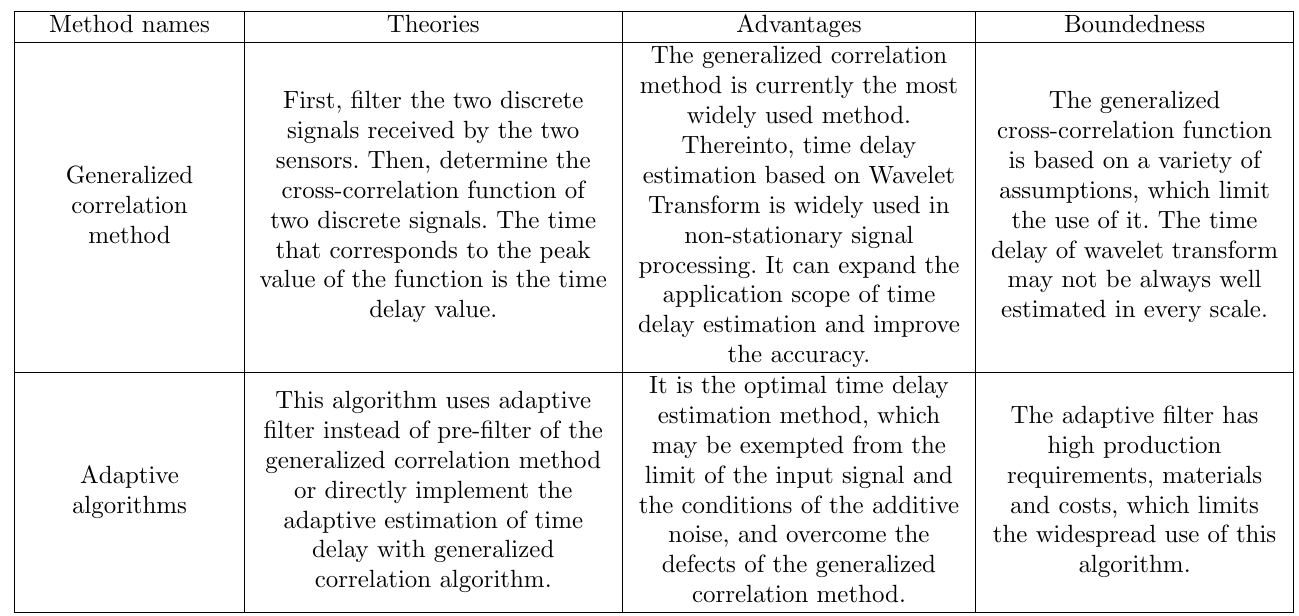
Table 7. Comparison sound sensor